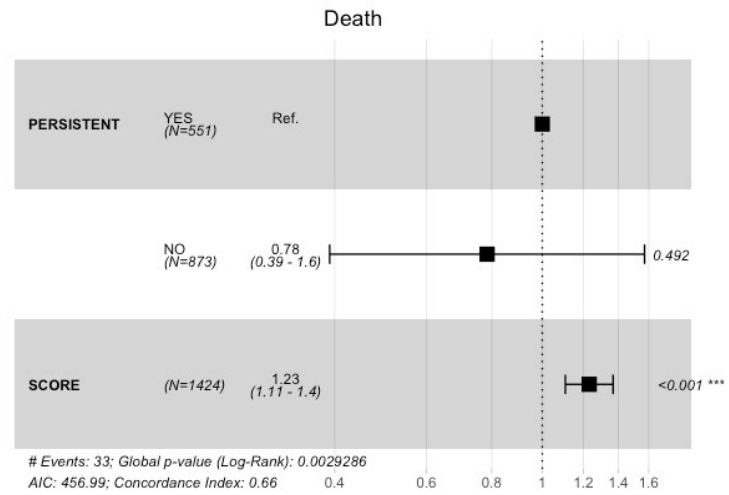
Figure 3. Persistence with lipid-lowering treatment and time to hospitalization, cardiovascular event, major adverse cardiovascular event (MACE), and death in men. Cox regression analyses adjusted by SCORE value.